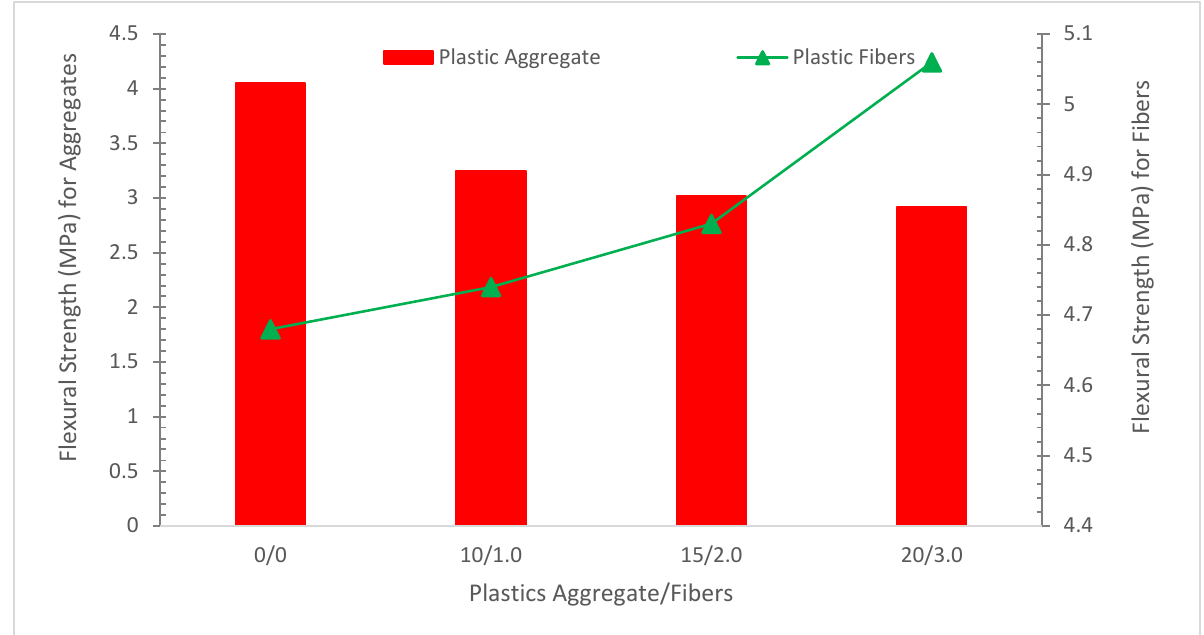
Figure 8. Flexural Strength (FLS): Data Source [26,49].